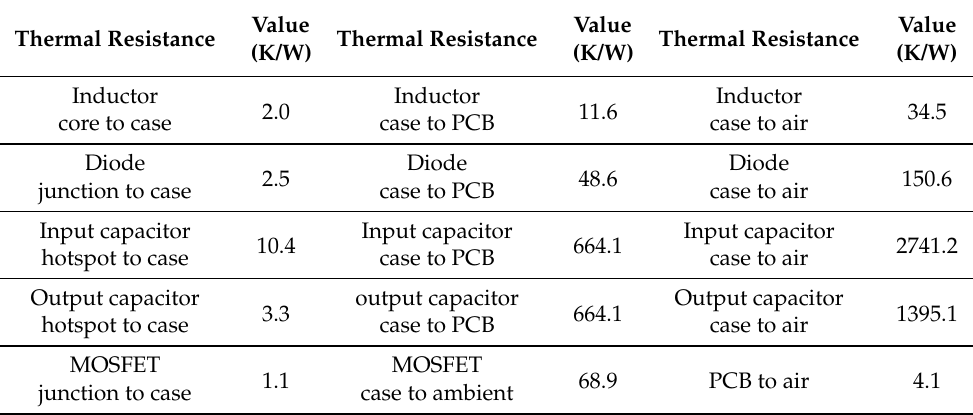
Figure 4. Steady state Foster thermal network of a three-leg interleaved boost converter. Table 2. The thermal resistances for the heat transfer of the converter’s components and PCB used in the thermal network of Figure